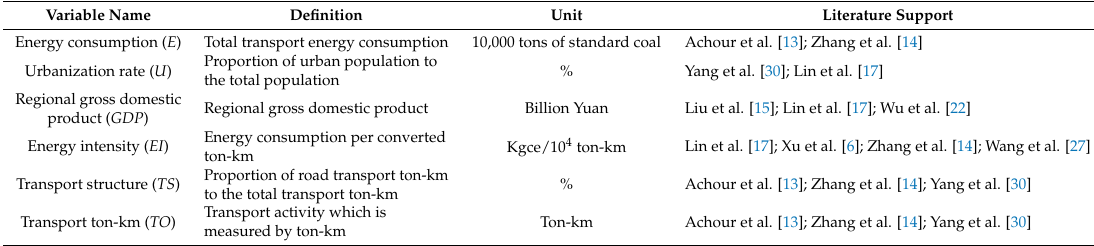
Table 1. Declaration of